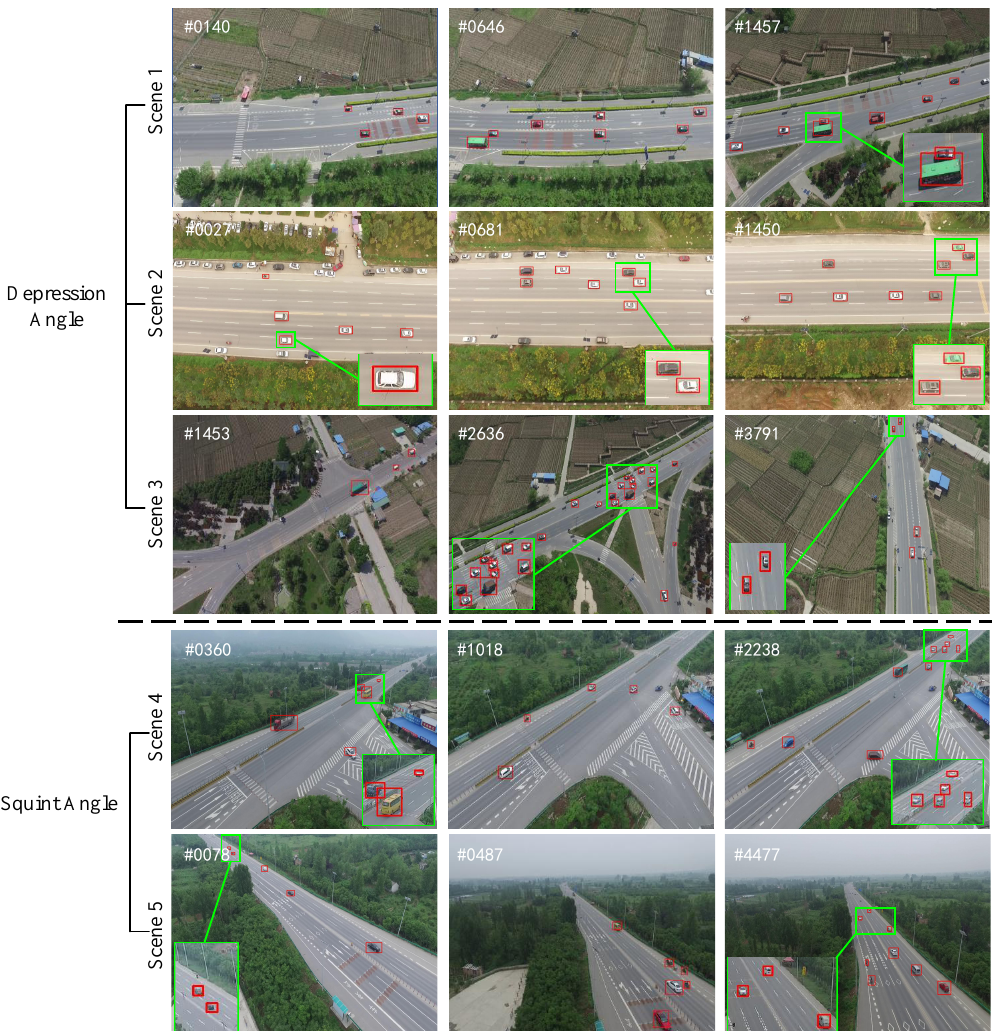
Figure 9. Some examples of small object detection results. The proposed method was evaluated in terms of the depression angle and splint angle. The number in the upper left corner is the frame number of each